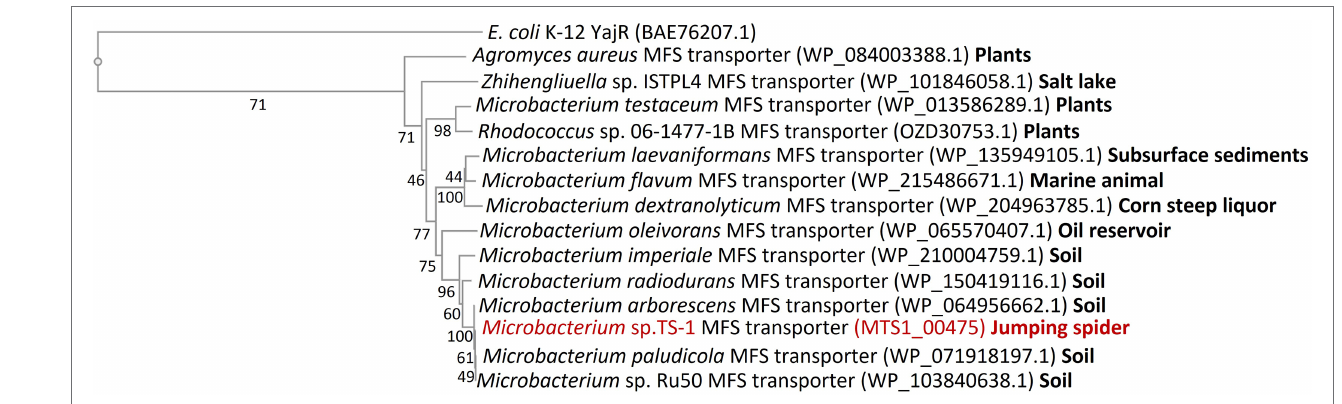
FIGURE 5 | Molecular phylogenetic tree analysis of MTS1_00475. A molecular phylogenetic tree was constructed based on multiple sequence alignment with the homolog of MTS1_00475. The details are described in the Materials and Methods section. MTS1_00475 from Microbacterium sp. TS-1 is shown in red. YajR from the major facilitator superfamily (MFS) of transporters of E. coli K-12 was used as an outgroup. The number between branches indicates the bootstrap value. The number after the bacterium indicates the GenBank accession number. The locations of isolation of the 13 strains harboring the MTS1_00475 homologs used to create the phylogenetic tree are shown in bold after each accession